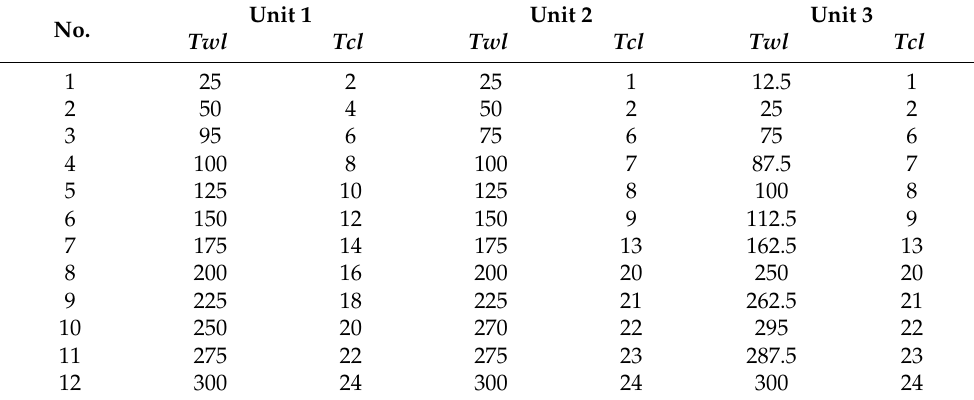
Table 1. Equipment life information.